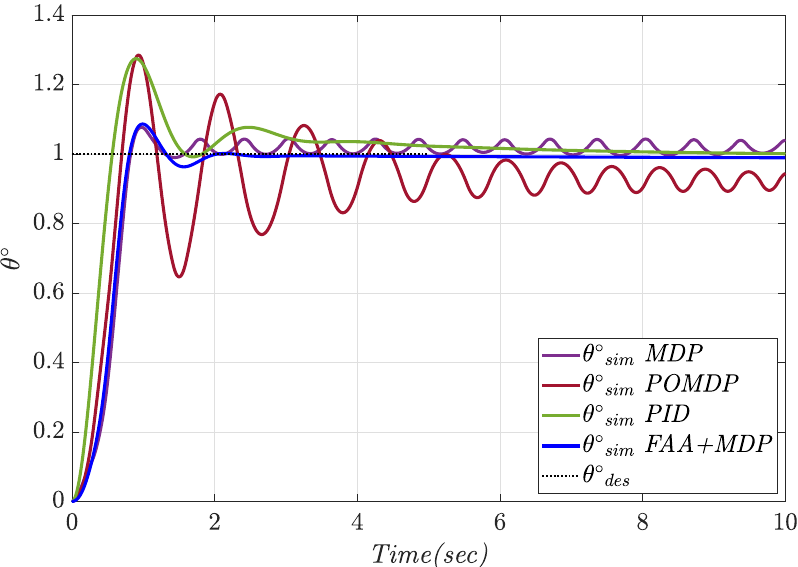
Figure 5. Performance of the improved Q-learning controller (using FAA) compared to MDP, POMDP, and PID controller.